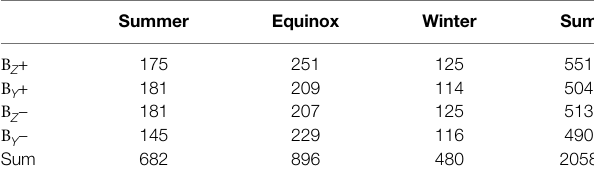
TABLE 1 | Summary of the amount of event in each group after imposing the criteria in Eq. 4 .